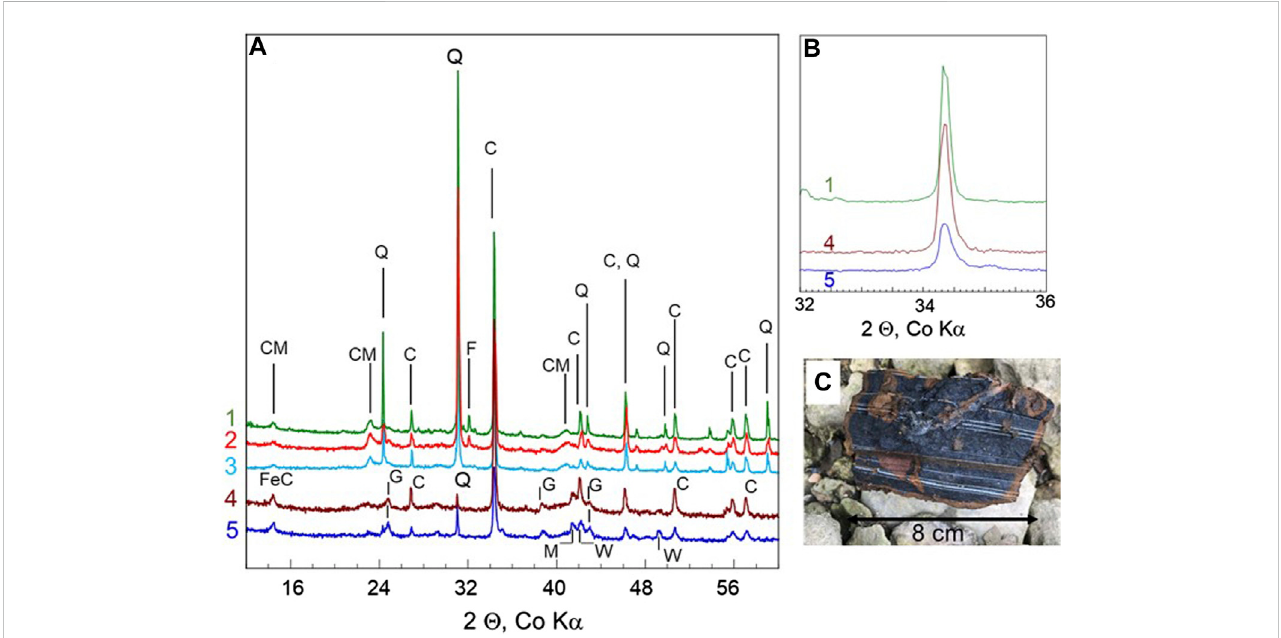
FIGURE 2 (A) XRDpatternsforJOSAN,JOEPandBETHUPsamples.Thethreetopcurvescorrespondtosurfacesedimentsatthethreeriverstationsfromupstream to downstream: 1: JOSAN surface sediment; 2: JOEP surface sediment; 3: BETHUP surface sediment. The two bottom curves represent deep layers of JOEP (4)andBETHUP(5)cores.Abbreviationsofmineralphases:quartz(Q);calcite(C);Feldspars(F);clayminerals(CM);magnetite(M);goethite(G);wustite(W);Fe- clays (FeC). (B) Zoom on calcite diffraction lines for deep samples at JOEP (4) and BETHUP (5). (C) Observation of the thin white calcium layers at